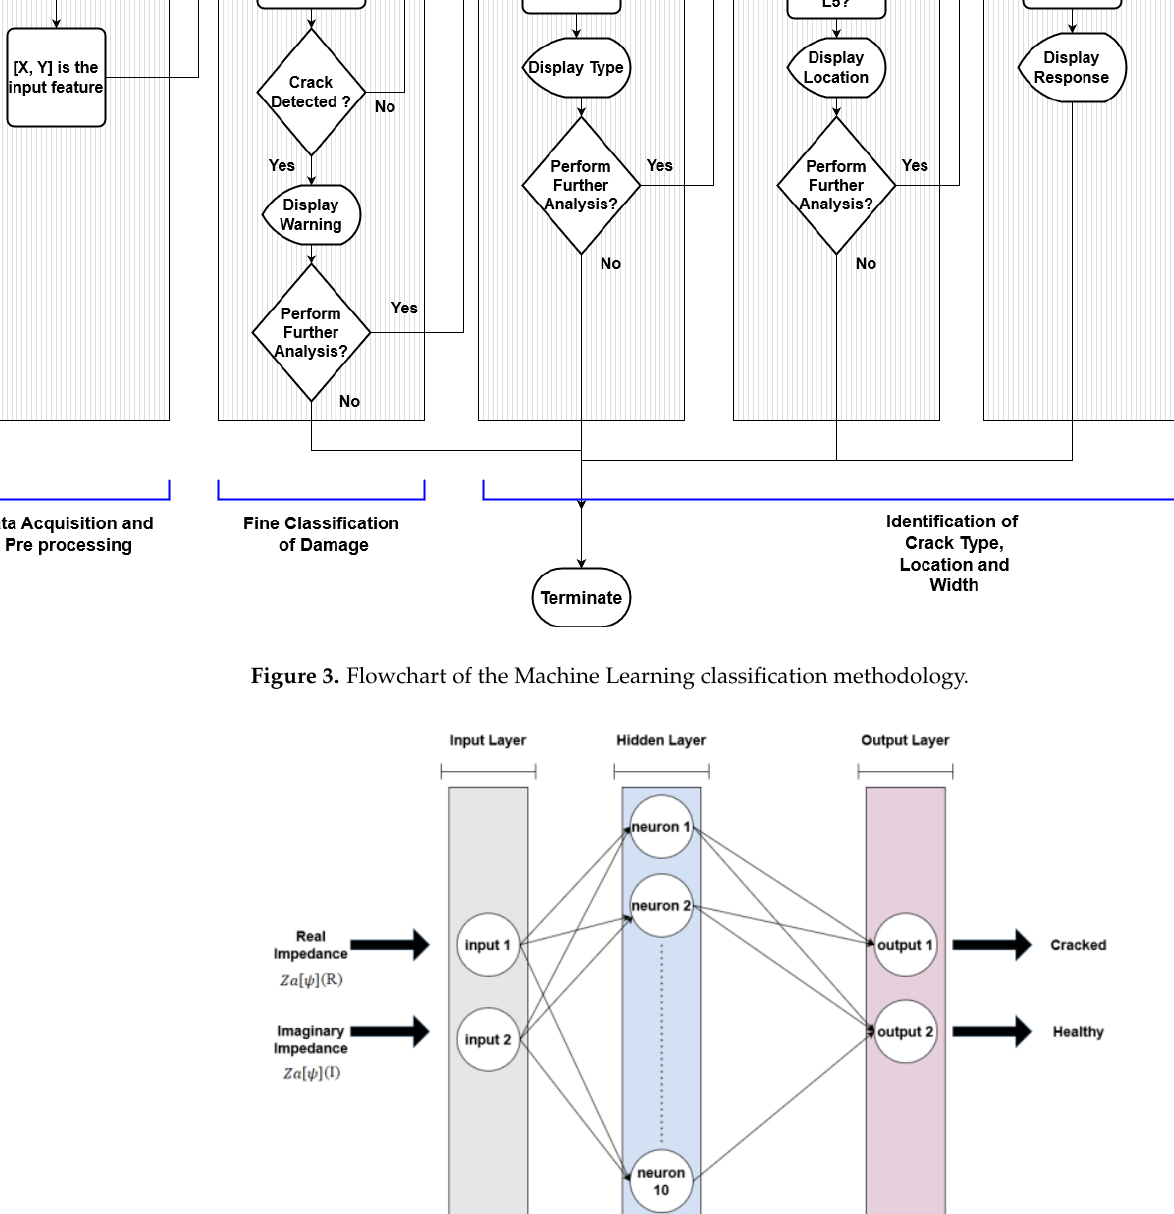
Figure 5. ANN structure showing. The input to the hidden layer of the network is varied and consists of either of the following, 1.